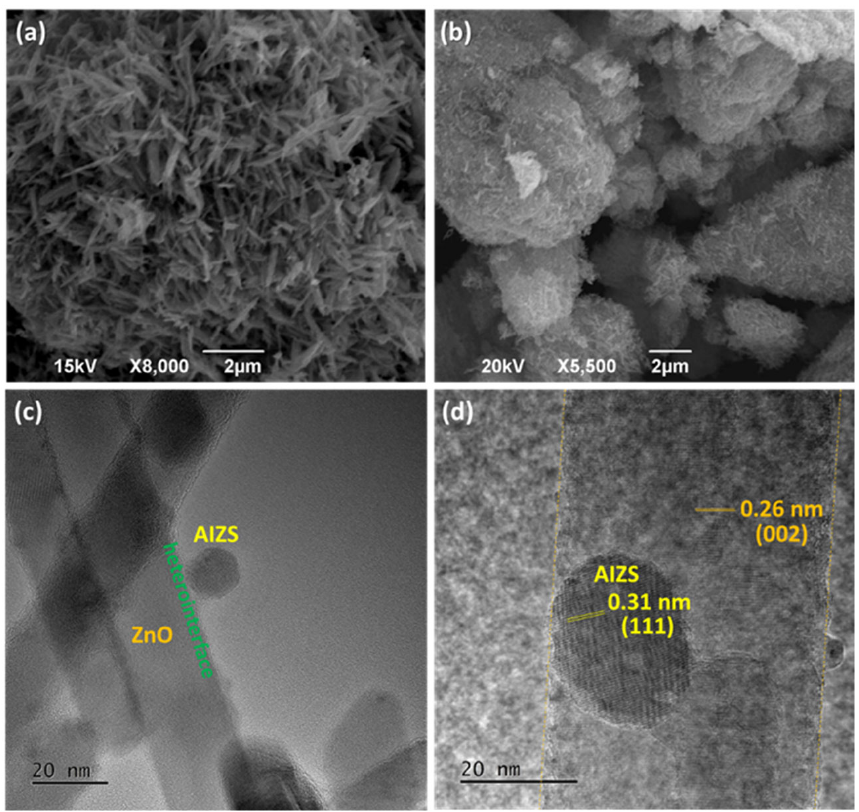
Figure 1. SEM images of ( a ) ZnO NRs and ( b ) the ZnO/AIZS(10) photocatalyst. ( c ) TEM and ( d ) HR ‐ TEM images of the ZnO/AIZS(10) photocatalyst. The HAADF ‐ STEM image of the ZnO/AIZS(10) photocatalyst and the corresponding elemental mapping images of Zn, O, S, Ag, and In elements further demonstrate the for ‐ mation of the heterostructured photocalyst and confirm that AIZS QDs are bound to the surface of ZnO NRs (Figure 2).